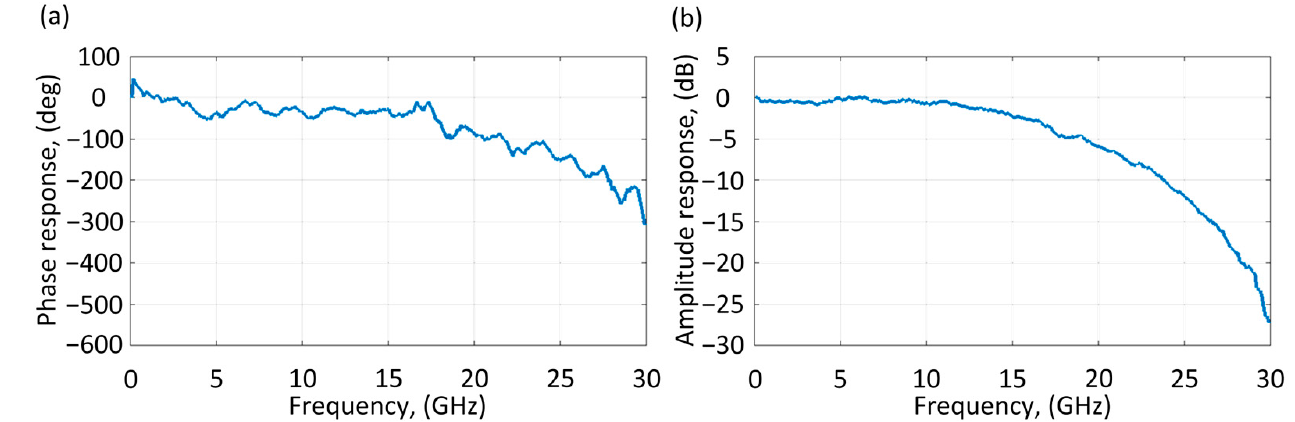
Figure 6. End-to-end system calibration using the EAWG for the OB2B configuration: ( a ) phase response and ( b ) amplitude response.